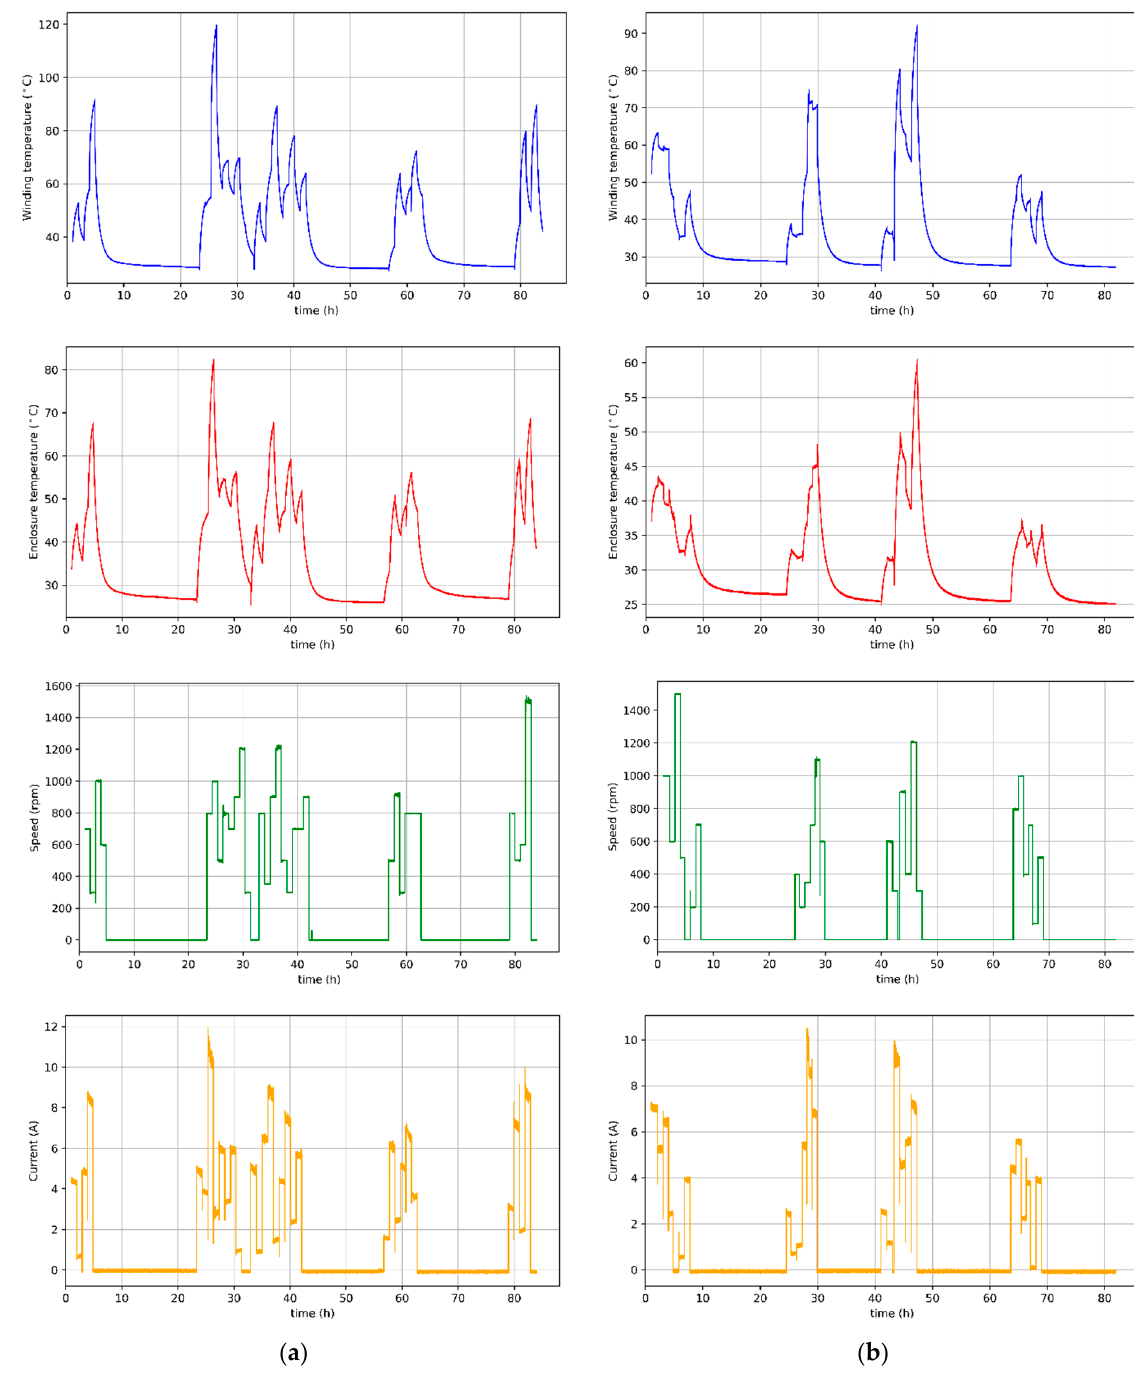
Figure 4. Measurement results of winding temperature (blue), casing temperature (red), speed (green), and current (orange) of motor: ( a ) without cooling; ( b ) with cooling fan.